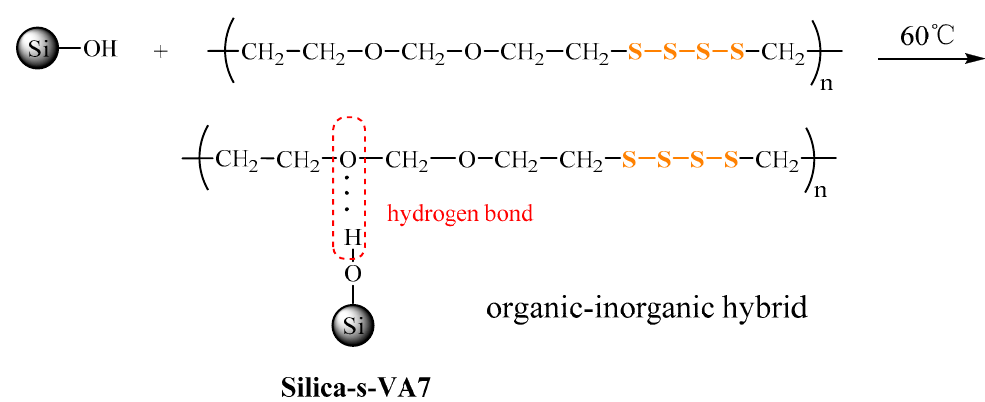
Figure 1. Synthetic route of silica-s-VA7.